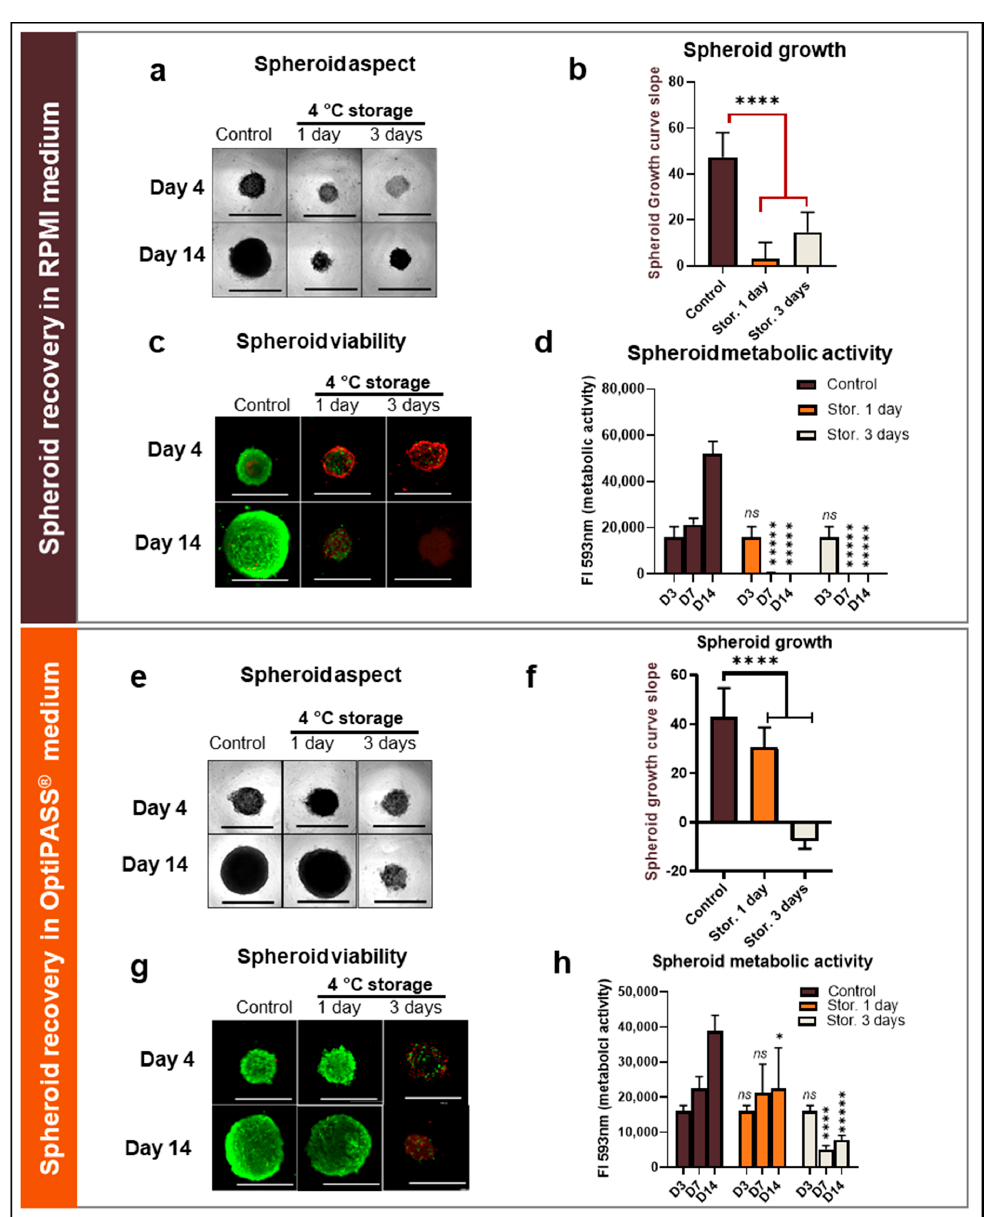
Figure 2. MDA-MB-231 spheroid preservation analysis after 4 ◦ C storage in RPMI1640 and OptiPASS ® media culture. Three-day-old spheroids were placed for 1 or 3 days at 4 ◦ C before being exposed to normal culture conditions—i.e., 37 ◦ C, 5% CO 2 in both RPMI1640 and OptiPASS ® medium cultures. Spheroid integrity aspect and size ( a ) in RPMI and ( e ) in OptiPASS ® were analyzed with bright field microscopy and object size algorithm (Cytation™3MV, Gen5, BioTek ® -M = 4X, scale bar = 1000 µ m). Spheroid cell proliferation was measured by the analysis of growth curve slopes between D4 and D14 ( b ) in RPMI and ( f ) in OptiPASS ® , reflecting proliferation capacities and recovery of cell spheroids after storage step. Spheroid cell viability after storage was analyzed by Live/Dead ® tests ( c ) in RPMI and ( g ) in OptiPASS ® with green fluorescence for viable cells and red fluorescence for dead cells, using Cytation™3MV equipped with GFP and IP fluorescence cubes (M = 4X, scale bar = 1000 µ m). Spheroid cell metabolic activity change after storage was quantified using the resazurin test ( d ) in RPMI and ( h ) in OptiPASS ® , at D3, D7 and D14 with normalized 593 nm Fluorescence Intensity (FI) measures. For each storage condition, significances compared to nonstored condition were indicated as ns (not significant; p > 0.05), * p < 0.05, **** p < 0.0001, ***** p <